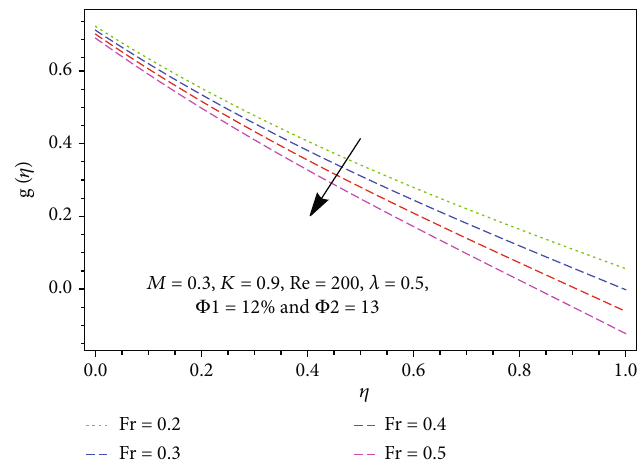
Figure 7: Impact of local inertial parameter Fr over momentum pro fi le g ð η Þ .